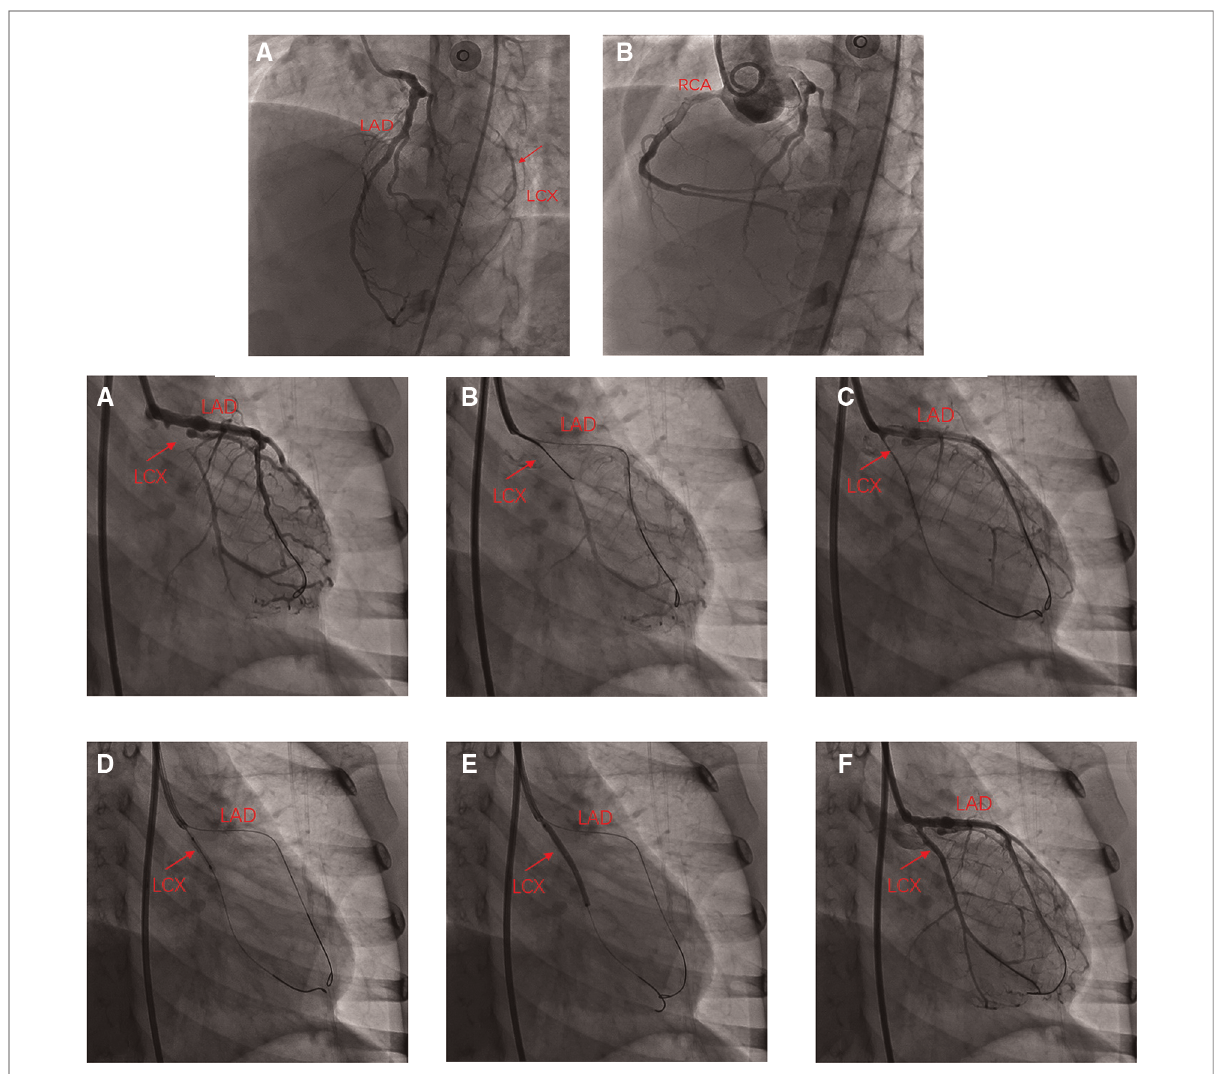
FIGURE 2 Angiography in left anterior oblique(LAO) 45° and cranial 25°: (A) total occlusion of the proximal LCX without calci fi cation and collateral vessels from the LAD to distal LCX. ( B ) Internal diameter of the RCA was nearly average. ( A ) Angiography in right anterior oblique (RAO) 30°: LCX occluded at the proximal end, and distal blood supply has relied on collateral vessels; ( B,C ) Recanalization of occluded LCX using antegrade crossing technique; ( D ) Angiography after balloon angioplasty showed patent LCX; ( E ) DCB was attached to the LCX for 60 s; ( F ) Angiography of the LCX after DCB